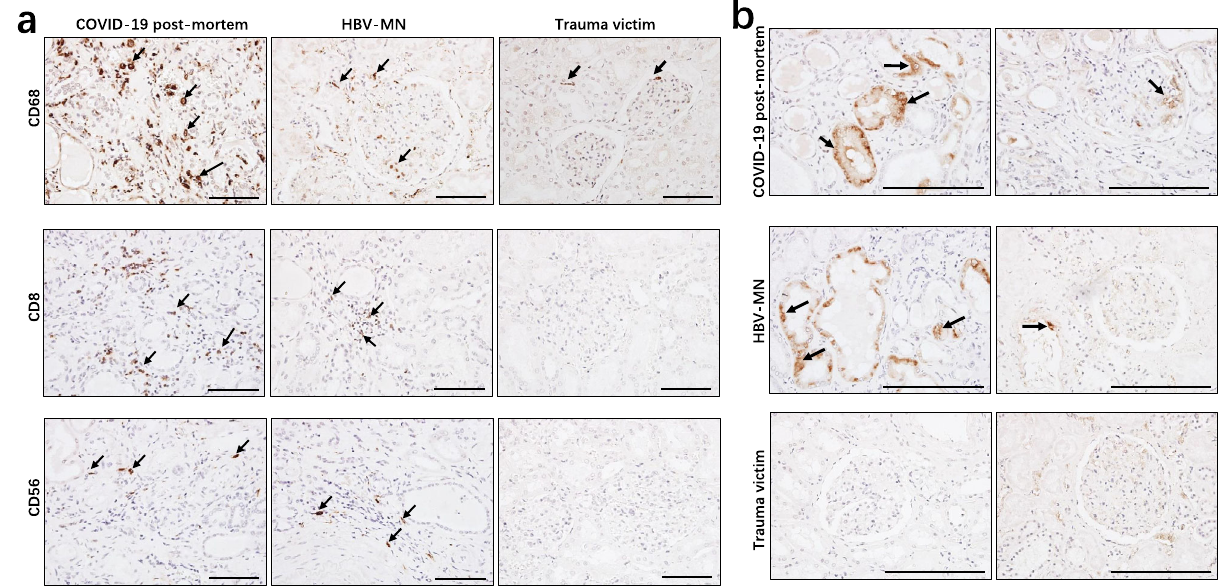
Fig. 5 Immunohistochemistry analyzed leukocytes and the complement C5b-9 in kidney tissues. Immunohistochemistry was used to detect the expression of a CD68, CD8, and CD56; b C5b-9 in kidney tissues from COVID-19 post-mortem (case #2), hepatitis B virus-associated membranous nephropathy (HBV-MN) and trauma victims. Arrow indicates positive cells. Scale bars = 200 μ m. Data represent one of at least three technical replication